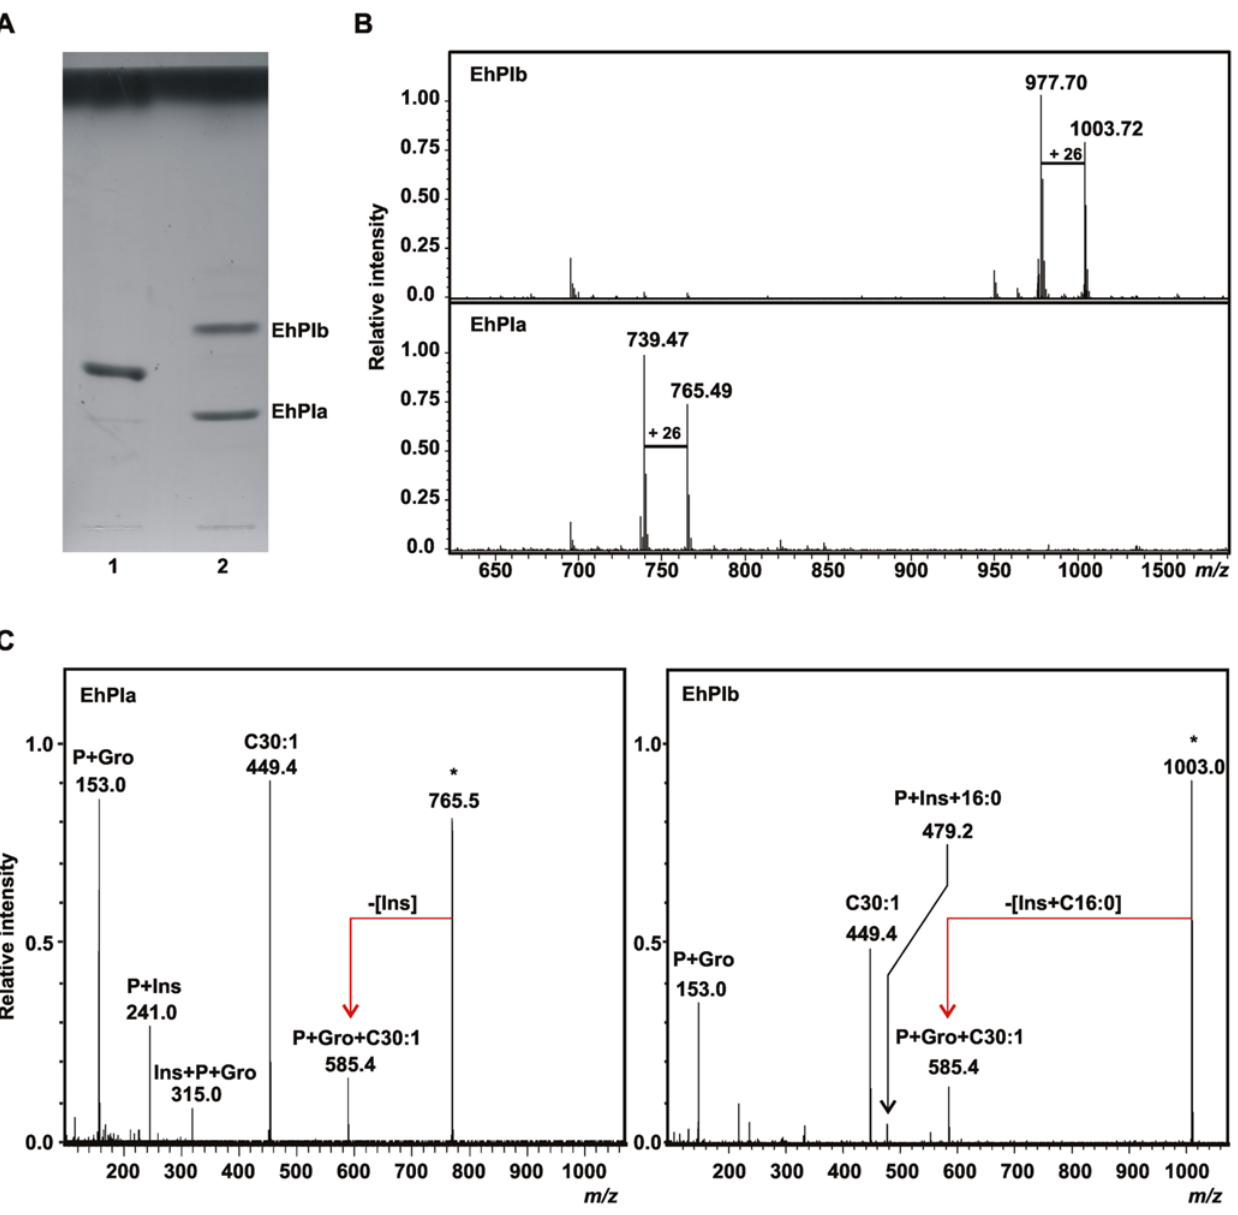
Figure 3. Structural characterization of the PI moieties of EhLPPG. (A) Thin-layer chromatography. Lane 1, PI from Sigma, lane 2 shows the two isoforms EhPIa and EhPIb obtained after nitrous acid deamination ofEhPI. (B) EhPIs were analyzed by ESIFT-ICRMS. Negative ion mass spectrum of EhPIa (upper) and EhPIb (lower). The [M]-26 corresponded to the exchange in the use of a 30:1 or a 28:1 fatty acid. EhPIs were further analyzed by ESI- IRMPD. (C) Negative ion mass spectrum of the major parent ions found in EhPIa and EhPIb shown in (B). doi:10.1371/journal.ppat.1000434.g003 at m/z 765.49 (EhPIa) and m/z 1003.72 (EhPIb) corresponded to the ion at m/z 241.0 and the presence of the pseudomolecular ions the molecules containing 30:1 (Fig. 3B). The fine structural at m/z 585.4 (showing the loss of the Ins + 16:0 fragment) as well as characteristics of both molecules were deduced after ESI-IRMPD at m/z 479.2 (P + Ins + 16:0), demonstrated a substitution with 16:0 experiments (Fig. 3C). For EhPIa, the presence of the daughter ion at position 2 of the Ins. Acylation of inositol was the only structural at m/z 241.0 (inositol-1,2-cyclic phosphate) identified the parent feature that differentiated EhPIb from EhPIa. Similar to EhPIa, ion as a PI and further indicated that the inositol ring was not the abundant presence of the ion at m/z 153.0 in EhPIb and the acylated at the position 2 [30]. The additional presence of only strong fatty acid carboxylate ion at m/z 449.4 (30:1), indicated a lyso -acyl anchor in this PI isoform as well [31]. Based on these one fatty acid carboxylate ion at m/z 449.4 (30:1) and the abundant presence of the ion at m/z 153.0 (cyclic glycerophos- results, the E. histolytica LPPG lipid anchors were assigned as 1- O - phate) identified this PI as a lyso -acyl anchor [31]. The ions at m/z (28:0)- lyso -glycero-3-phosphatidylinositol for EhPIa and 1- O - 585.4 and m/z 315.0 corresponded to P + Gro + 30:1 and In- [(28:0)- lyso -glycero-3-phosphatidyl-]2- O -(16:0)-inositol for EhPIb s + P + Gro, respectively. In the case of EhPIb, the virtual absence of (Fig. 4A). Interestingly, stimulation of lymphocytes in the presence